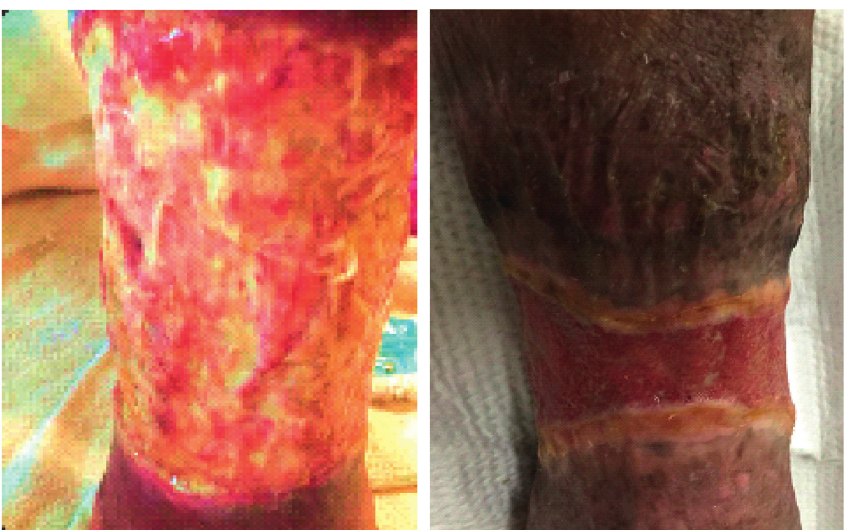
Figure 1: Skin ulcer with prominent fibrinous material and surrounding